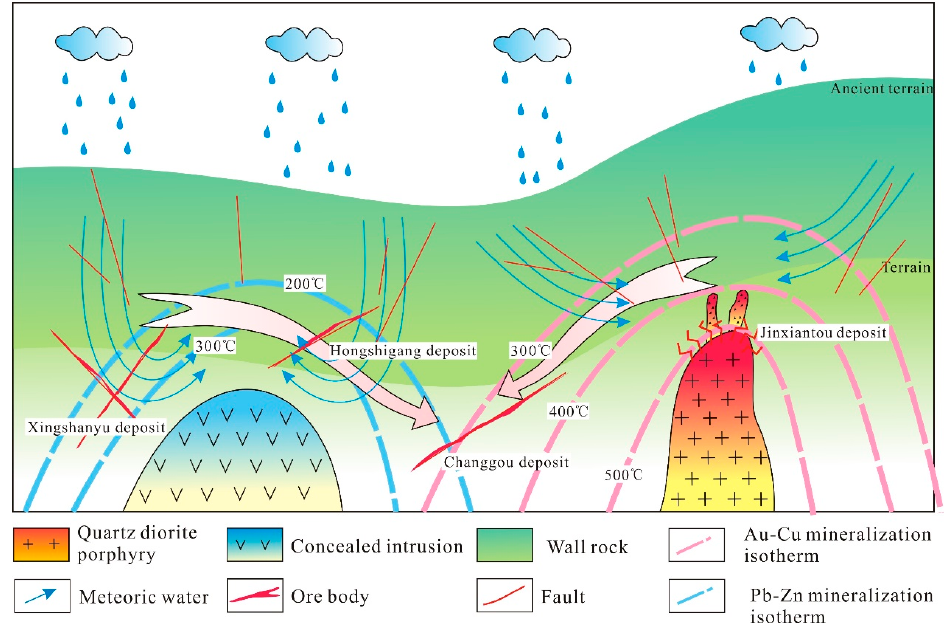
Figure 13. Metallogenic model for the Qibaoshan polymetallic ore field.